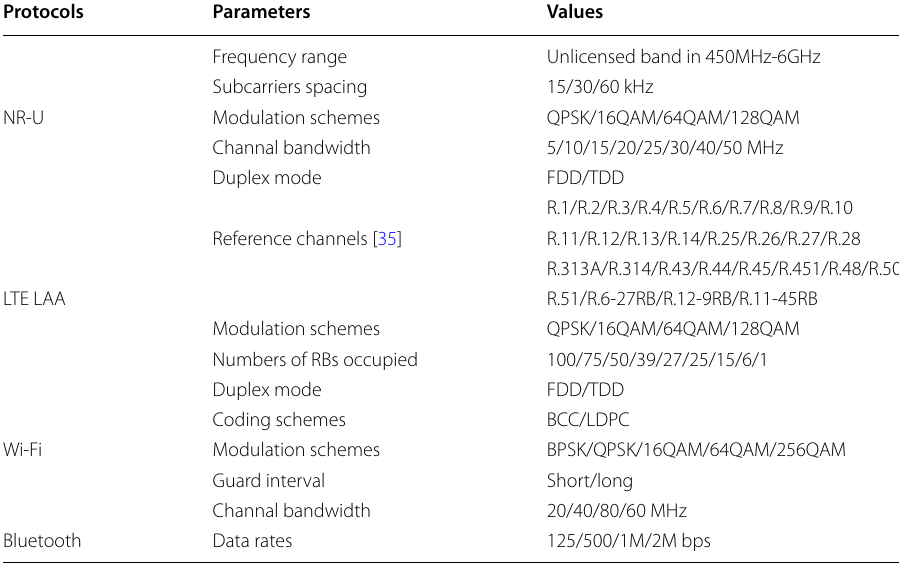
Table 3 Parameters of waveform generation